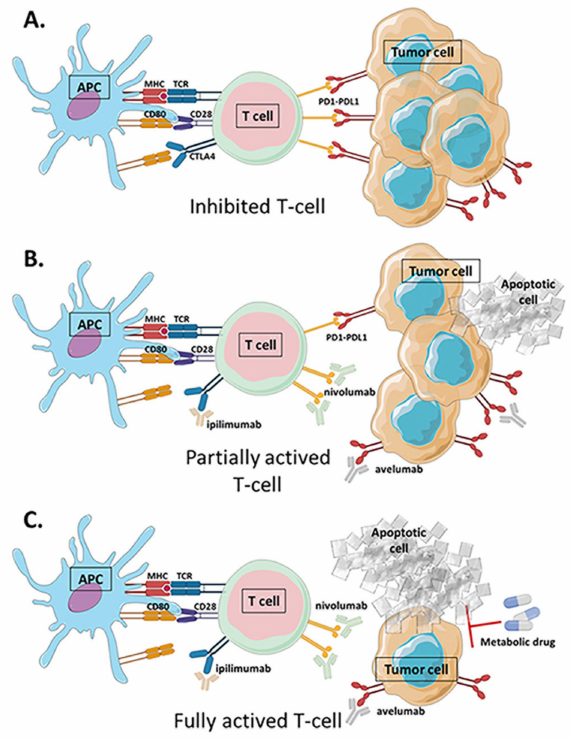
Figure 5. Immune checkpoint blockade strategies to enhance antitumor immune response. ( A ) Immune checkpoints (PD1–PDL1–CTLA4) overexpressed in many tumors inhibit the